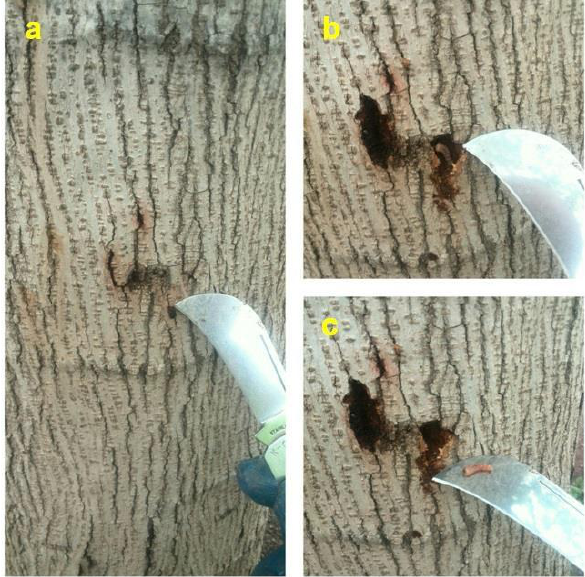
Figure 6. X. chinensis larva within its feeding cavity in the phloem of a mulberry tree trunk. The sequential images ( a – c ) show the process of exposing such larval cavities. Note the tiny frass protrusions through slits and cracks on the periderm (bark) in image ( a ) hardly reveal the presence of the beetle larvae underneath. (Photos Jordi Serra). Insects 2018 , 9 , x FOR PEER REVIEW